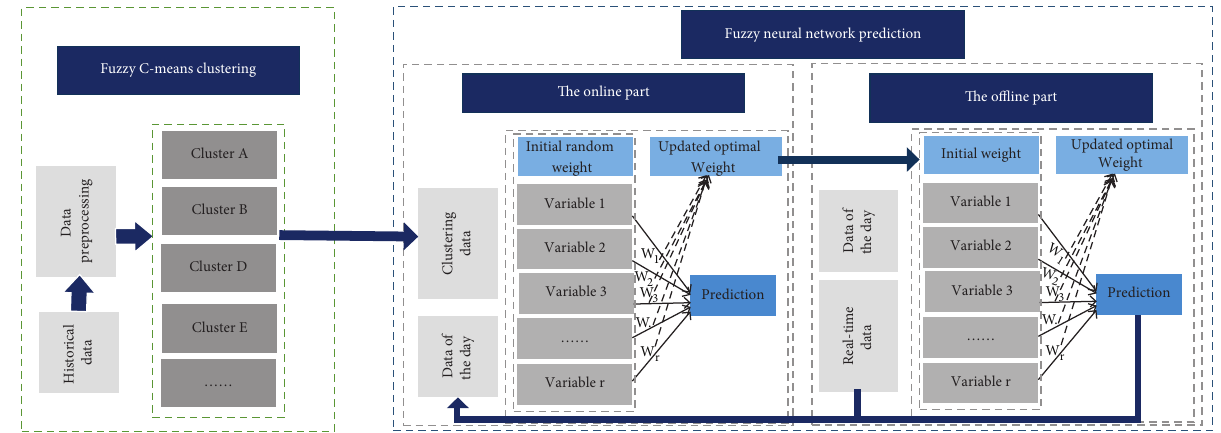
Figure 1: The overall framework of the FNN prediction